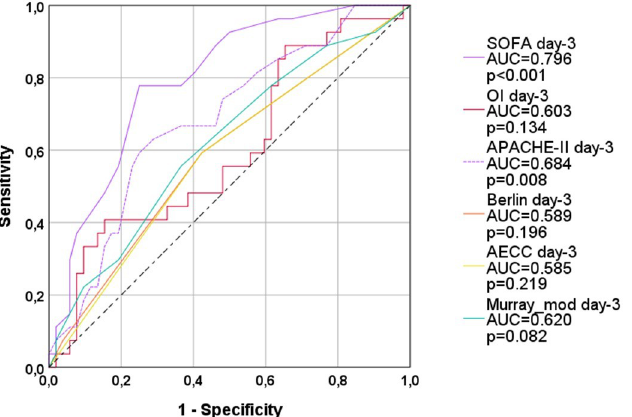
Fig 3. ROC-AUC regarding 28d-mortality (all patients; day 3). OI: oxygenation index; AECC: American European Consensus Conference; Murray_mod: modified Murray-score (sum of points without radiological points); AUC: area under the curve. APACHE-II: Acute Physiology And Chronic Health Evaluation; SOFA: Sequential Organ Failure